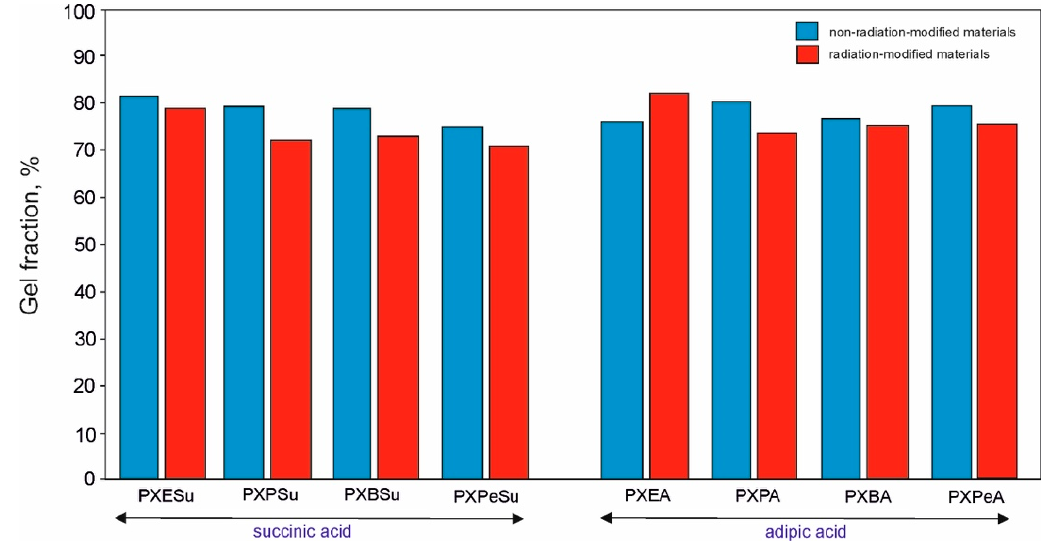
Figure 13. Gel fraction results for PXESu, PXPSu, PXBSu, PXPeSu and PXEA, PXPA, PXBA, and PXPeA nonradiation-modified materials (blue) and radiation-modified materials (red ).